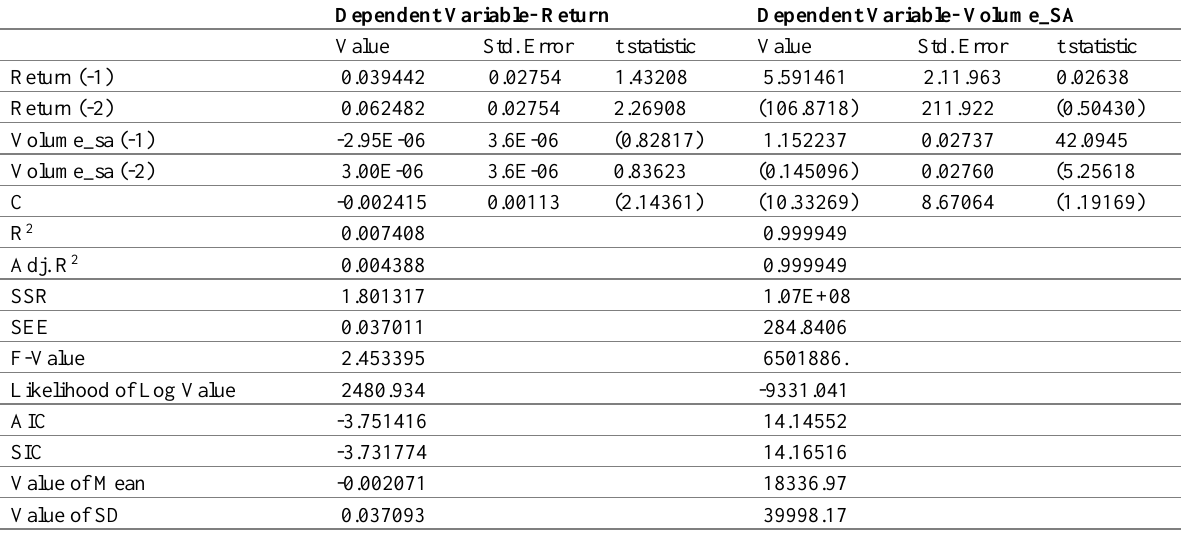
Table 3: Result of Panel VAR Between Return and Seasonally Adjusted Volumes of Stocks for Public